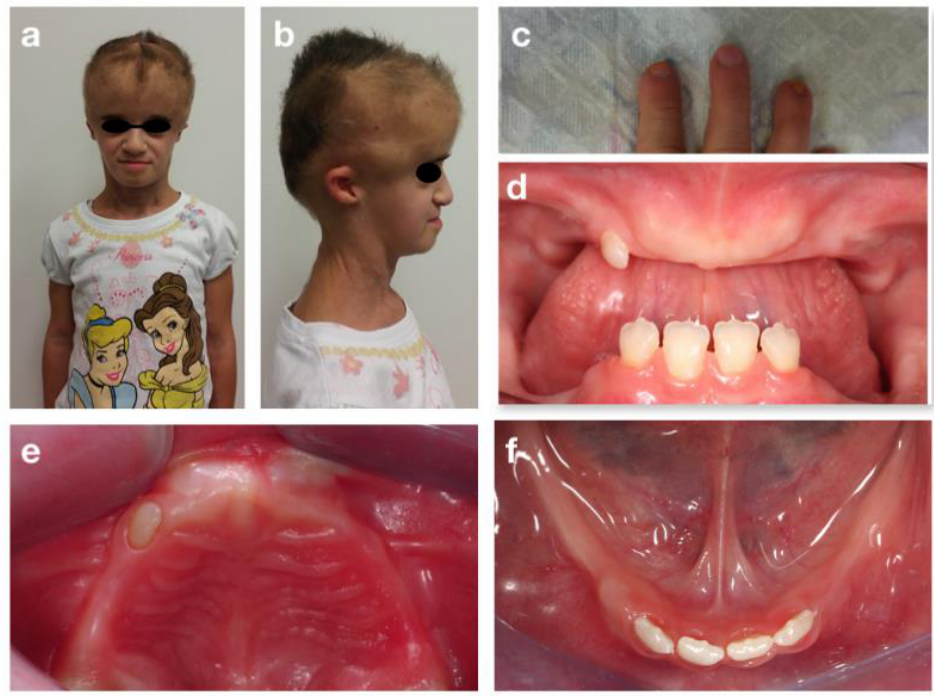
Figure 7. Progeroid syndrome: extra-oral ( a , b ), fingers ( c ) and intra-oral ( d – f ) pictures at the first visit.